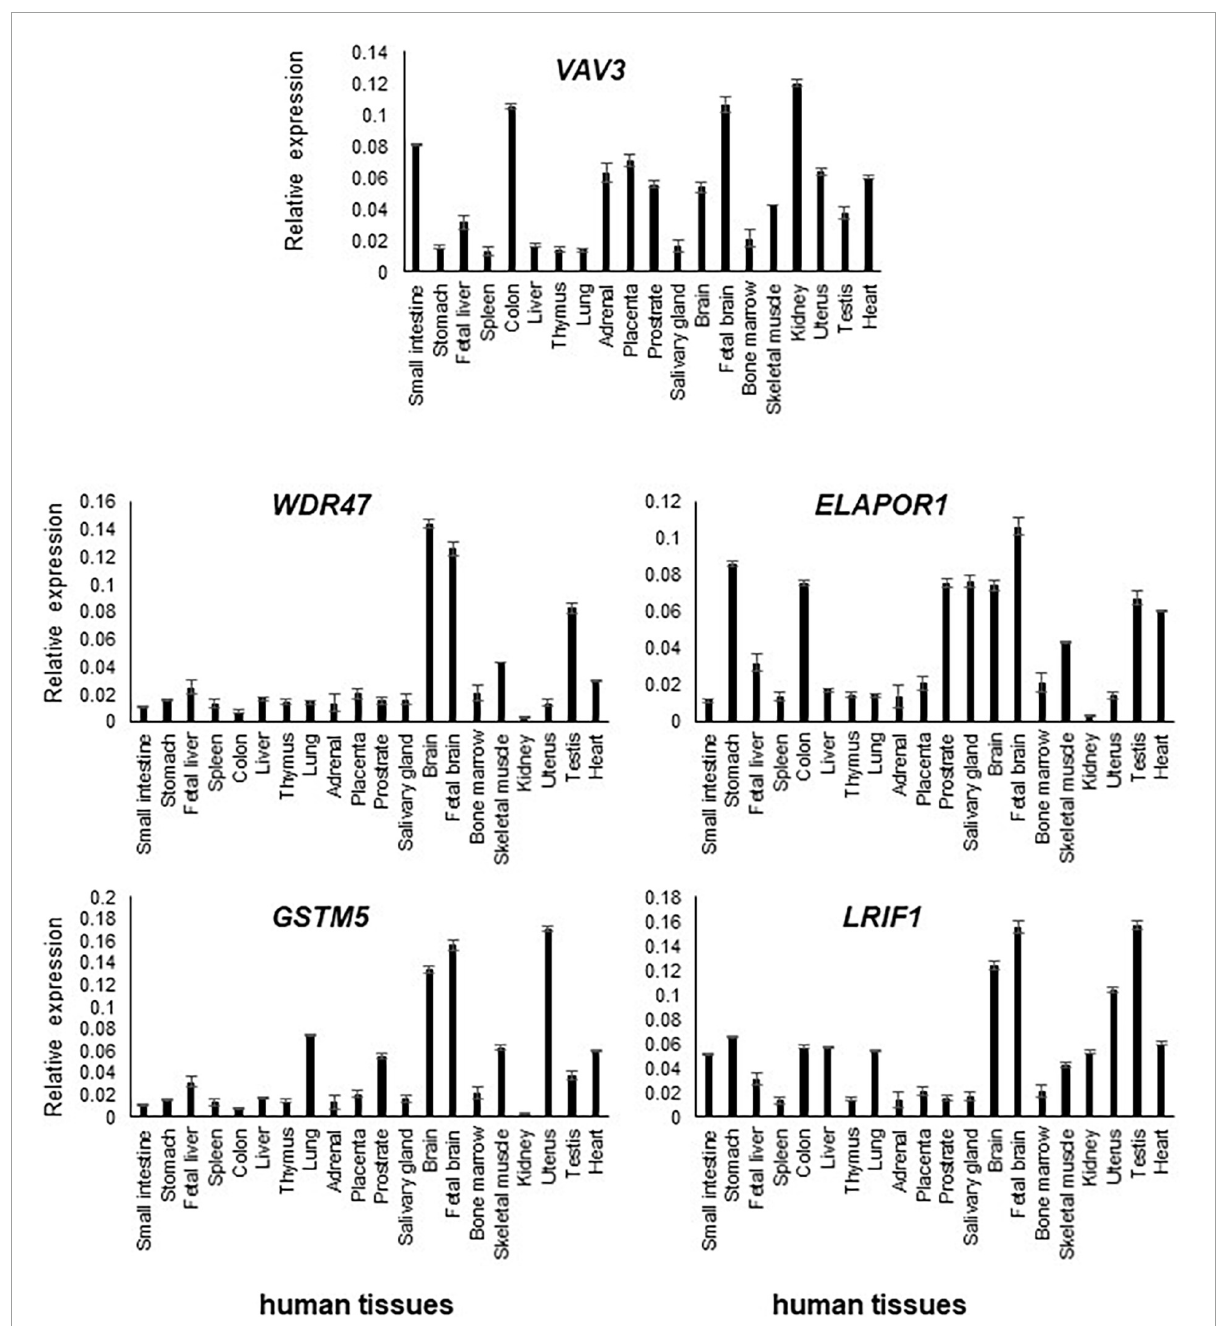
FIGURE2 Transcript levels of VAV3, ELAPOR1, WDR47, GSTM5, and LRIF1 in various human tissues were determined by RT-qPCR. Relative high expression of them was detected in the adult and fetal brain compared to other tissues.